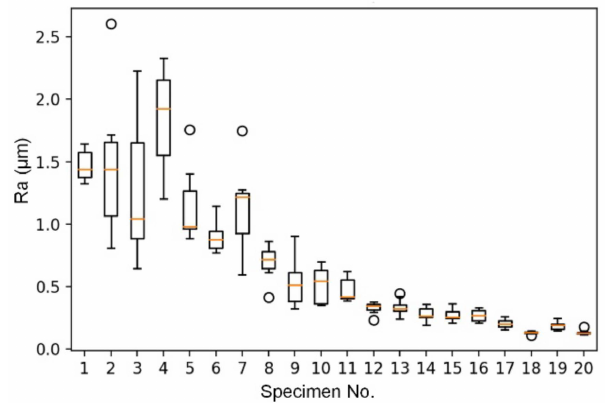
Figure 15. The box-and-whisker plot of the surface roughness Ra of the